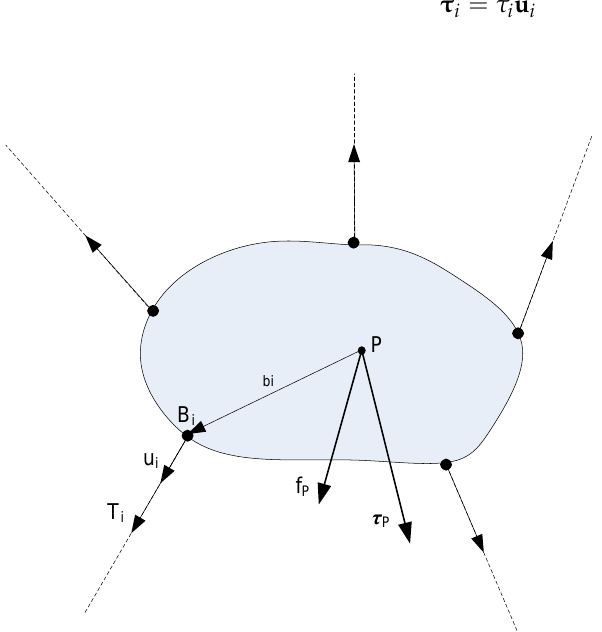
Figure 3. Wrench diagram of the moving platform. where F p and M p are the vectors of the external forces and torques acting on the mobile platform, respectively; τ i is the force vector that each cable acts upon on the end-effector; and b i vectors are the positions of the distal attachment point B i on the mobile platform relative to the origin of Op, given in local coordinates of the frame OP. From the cable direction show in Figure 3, with the unit vectors u i , the direction of the forces τ i can be obtained as below.